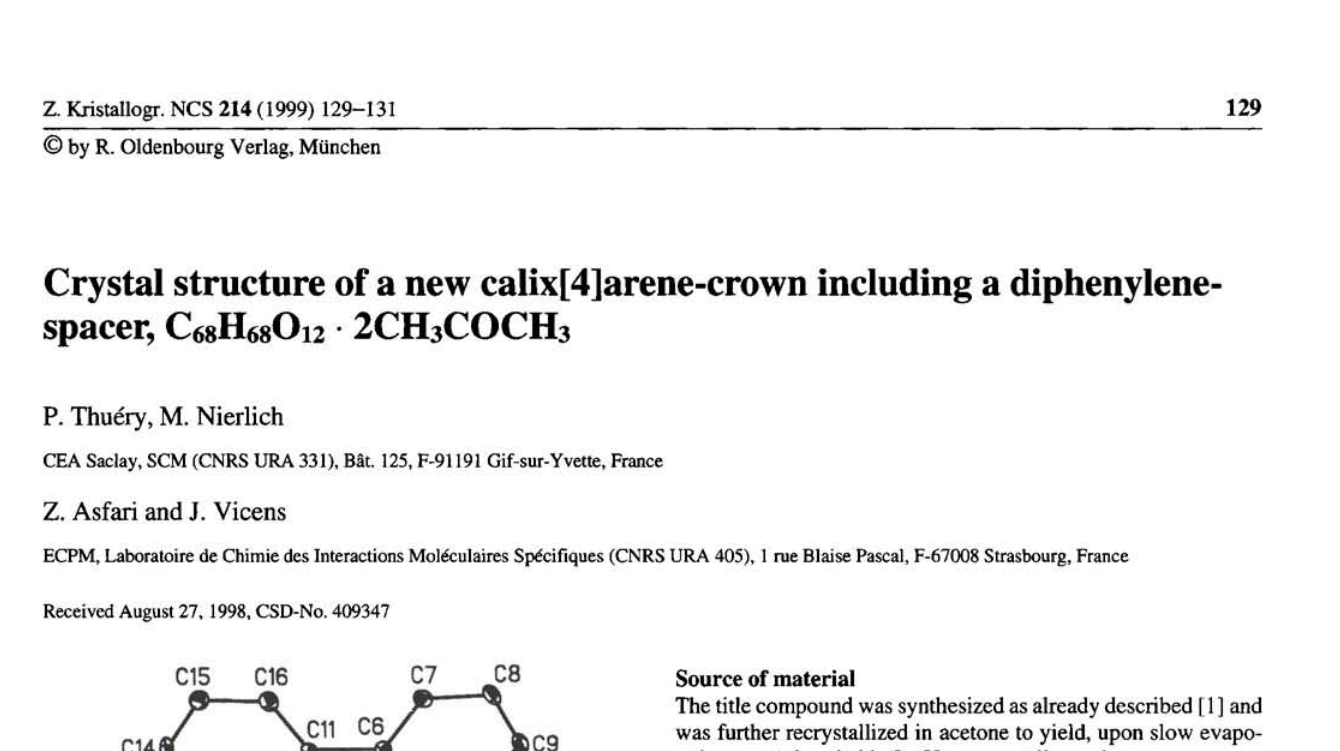
Table 1. Data collection and handling.